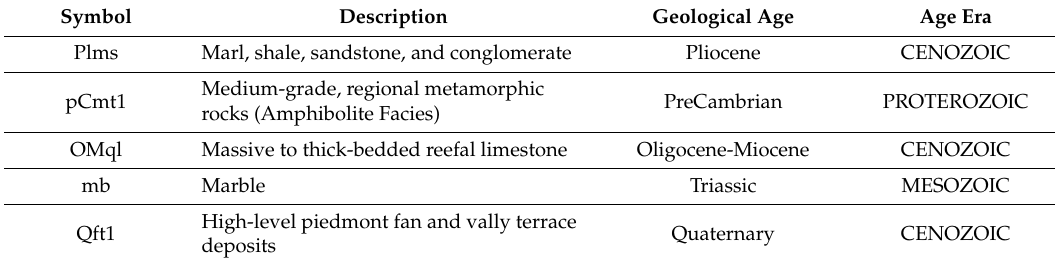
Table 2. The description of the lithology